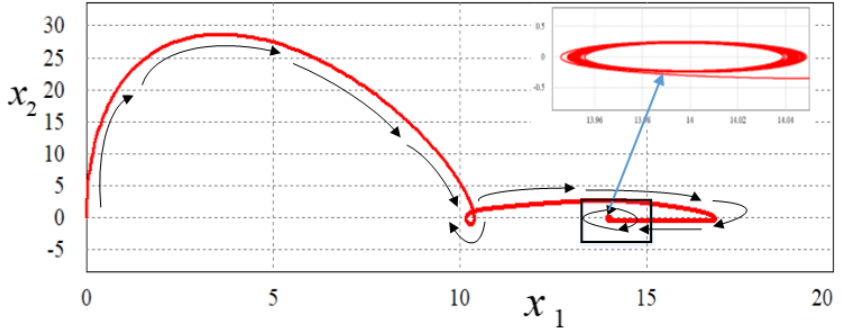
Figure 7. Phase plot showing the stability of the overall system with NTSM controller.